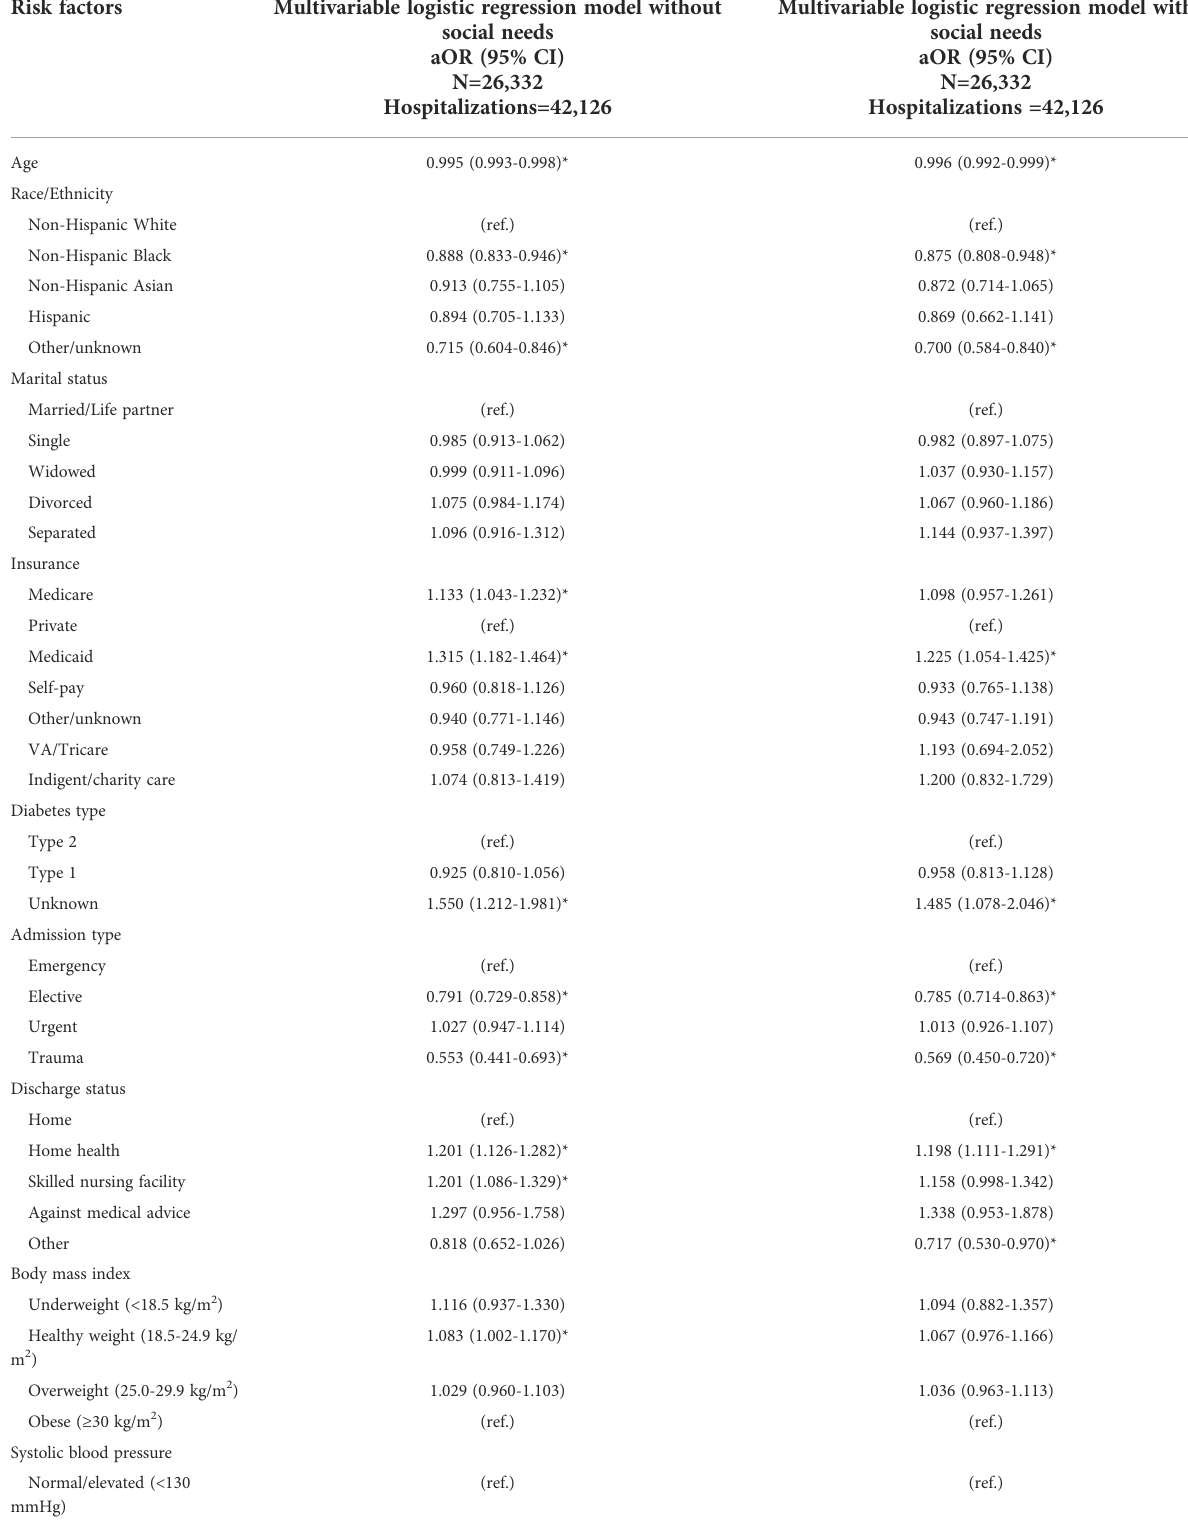
TABLE 3 Logistic regression models for all-cause 30-day